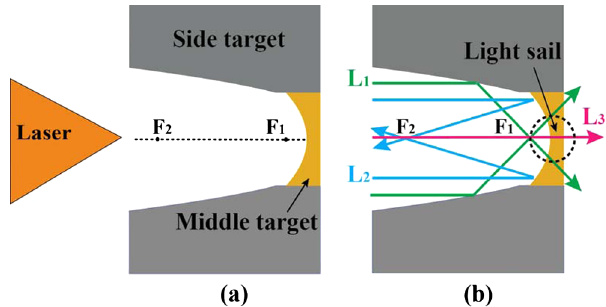
FIG. 1. (a) Schematic view of the dual parabola target (DPT) design. Focus 1 is the focus of the parabolic inner wall of the side target and focus 2 is the focus of the parabola-shaped front surface of the middle target. The middle target is marked by a dashed black rectangle. (b) The schematic plot of the intended geometrical light path during the interaction